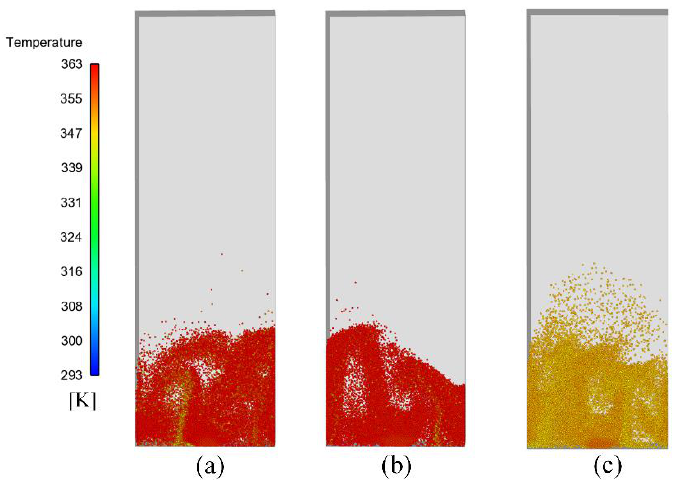
Figure 5. Schematic diagram of particle behaviors and temperature distribution when time is ( a ) 2 s,